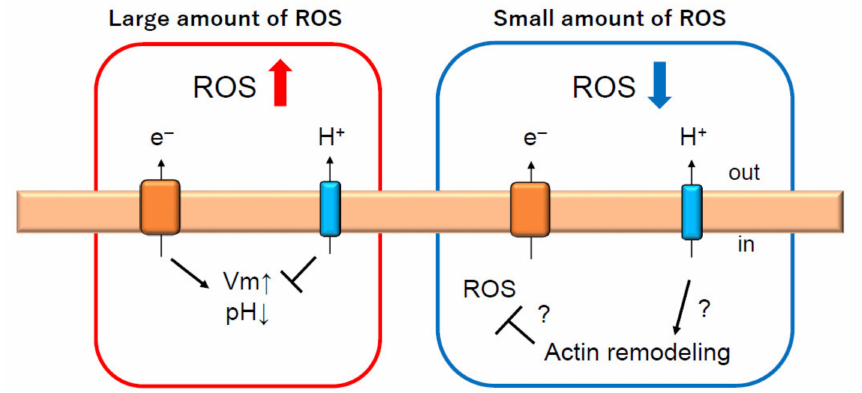
Figure 4. Hv1/VSOP is two-way player regulating ROS production in neutrophils. Under conditions of phagocytosis, which requires a large production of ROS, Hv1/VSOP promotes ROS production to compensate charge imbalance induced by NADPH oxidase activation [12,22,26,28]. However, under conditions when a small amount of ROS is produced, Hv1/VSOP inhibits ROS production [25], which might be regulated through actin remodeling [20,22]. Arrow and T arrow indicate promotion and inhibition, respectively, for Vm, pH, ROS and actin remodeling. Red and blue arrow indicate increase and decrease of ROS production,